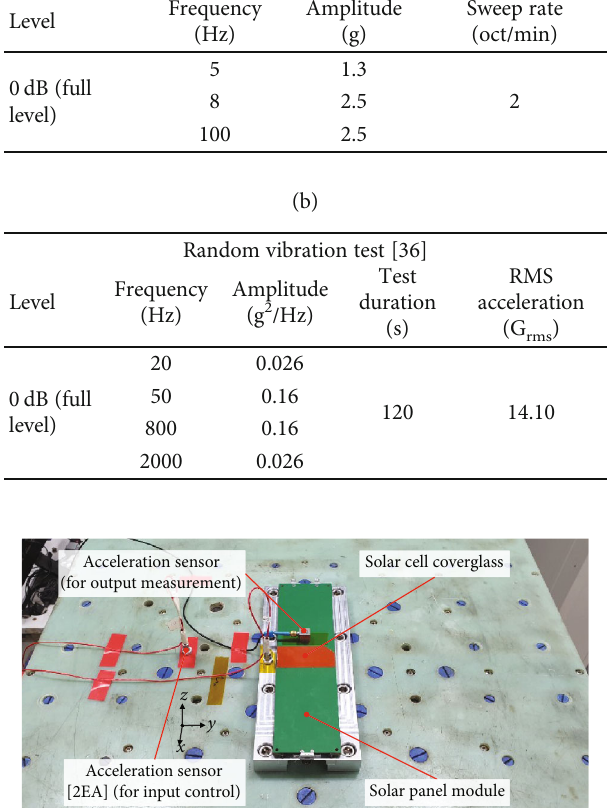
Figure 10: Launch vibration test setup con fi guration of the demonstration model of the 3U solar panel module.